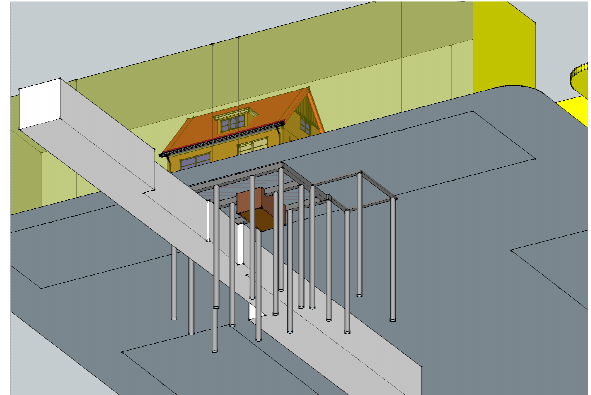
Figure 9. An object below the surface with archaeological value has been taken into account in the structural design Step 5: The architect uploads the IFC model to the building permit portal